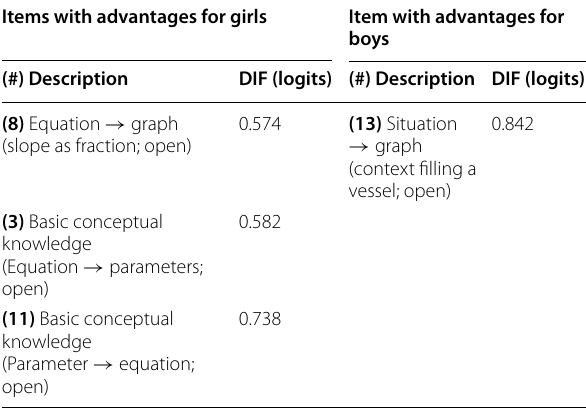
Table 3 Test items with more than 0.5 logits DIF with regard to